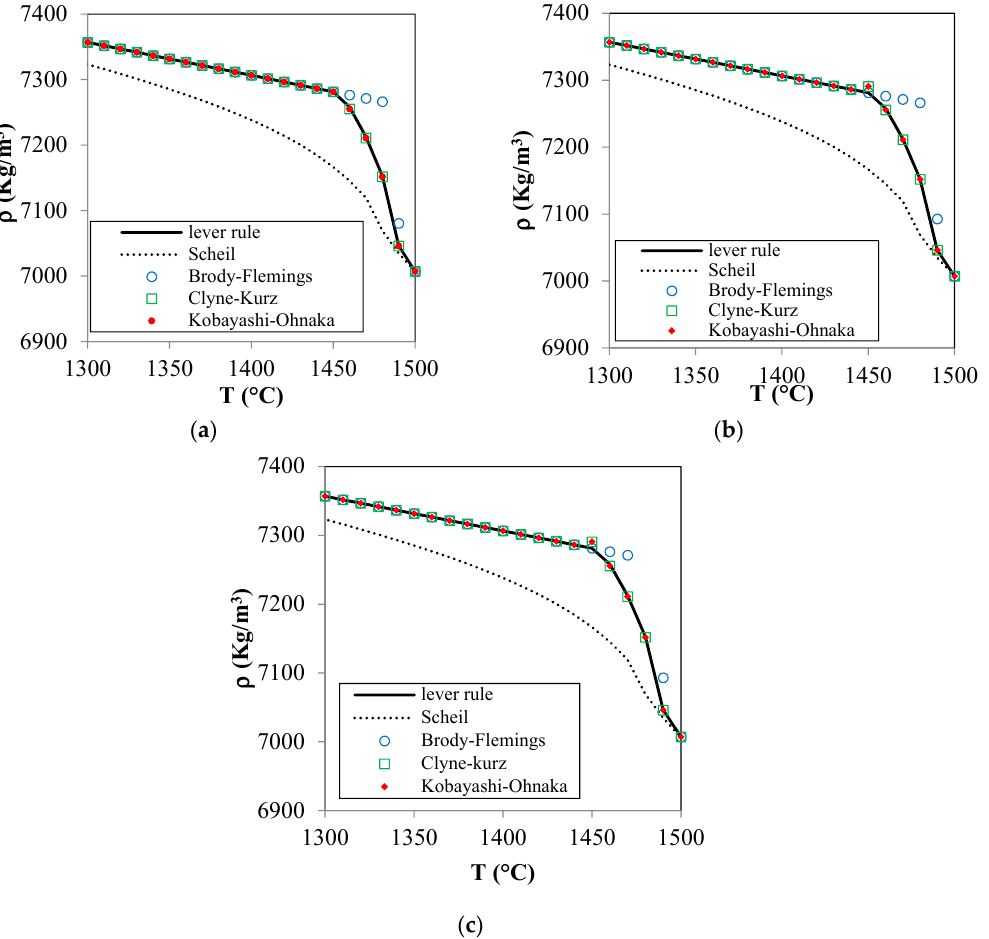
Figure 7. Temperature dependence of density for the steel in study according to different microsegregation solidification models for the case: ( a ) α = 10.57 (ingot wall side); ( b ) α = 12.60 (mid-radius region); ( c ) α = 12.66 (ingot center).